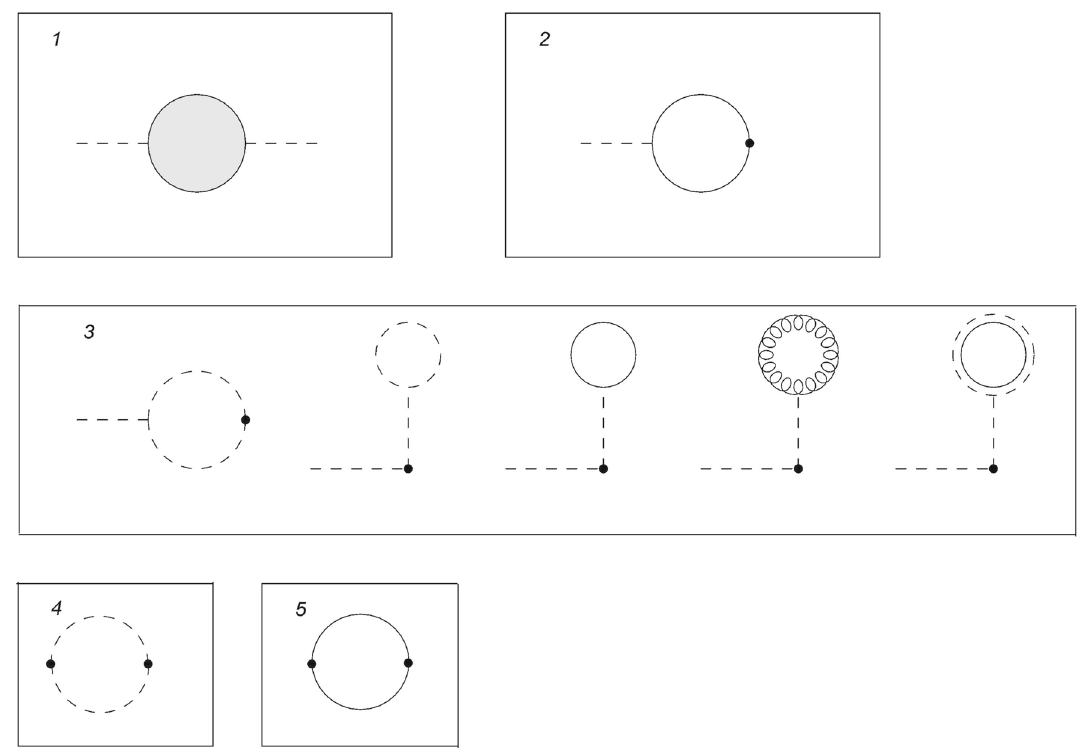
Fig. 10 One-loop contributions for the propagator (cid:2) O ( x ) O ( y ) (cid:3) . Curly lines represent the gauge field, dashed lines the Higgs field, solid lines the Goldstone boson and double lines the ghost field. The • indicates the insertion of a composite